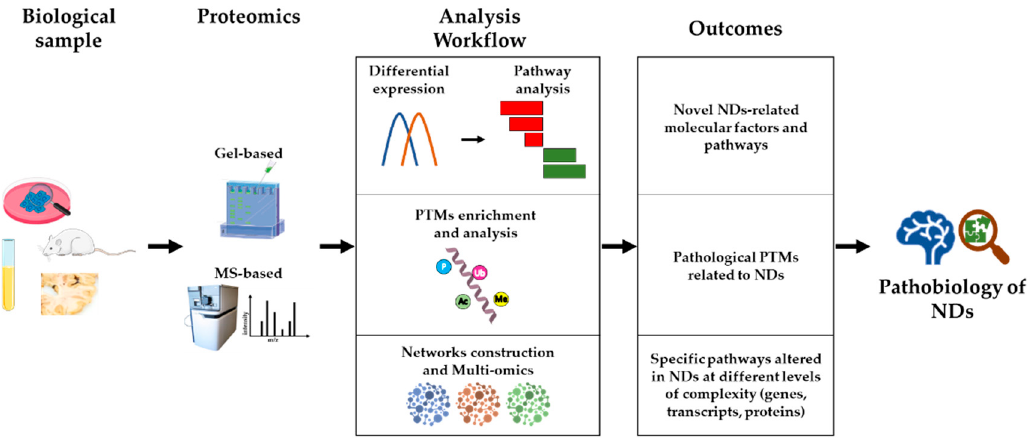
Figure 1. Proteomics as a tool for studying NDs pathobiology. Starting from several types of biological samples (cellular and animal models, biofluids, and patient-derived tissues), both gel-based and MS-based proteomics techniques can be used to investigate the pathobiology of NDs. Protein quantification, followed by differential expression analysis and pathway analysis, allows the identification of novel NDs-related molecular factors and pathways (see Section 2.1). Proteomics strategies have also been developed to enrich and analyze specific PTMs, leading to the identification of NDs-related protein modifications (see Section 2.2). Ultimately, the generation of networks of physically/functionally interacting molecules (proteins, transcripts, genes, metabolites) represents a tool for multi-level functional analysis, leading to the identification of specific pathways altered in NDs (see Section 2.3). PTMs: post-translational